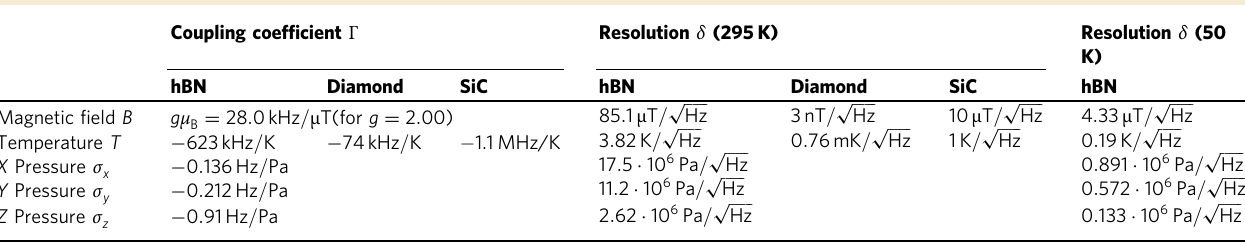
Fig. 5 Experimental (diamonds) and simulated (dark and light blue traces) resonant frequencies of V − B for different temperatures and magnetic fi elds. a ODMR measurements (pink diamonds) at B < 20 mT. b cw EPR measurement at T = 5 K and microwave frequency of 9.4 GHz (light green) and electron spin-echo measurements at T = 8 K and 94 GHz (dark green). Note the axes are shifted for better visibility and comparability. Table 2 Three spin hosting systems in comparison: coupling coef fi cient Γ and general resolution δ at room ( T = 295 K) and cryogenic ( T = 50 K)